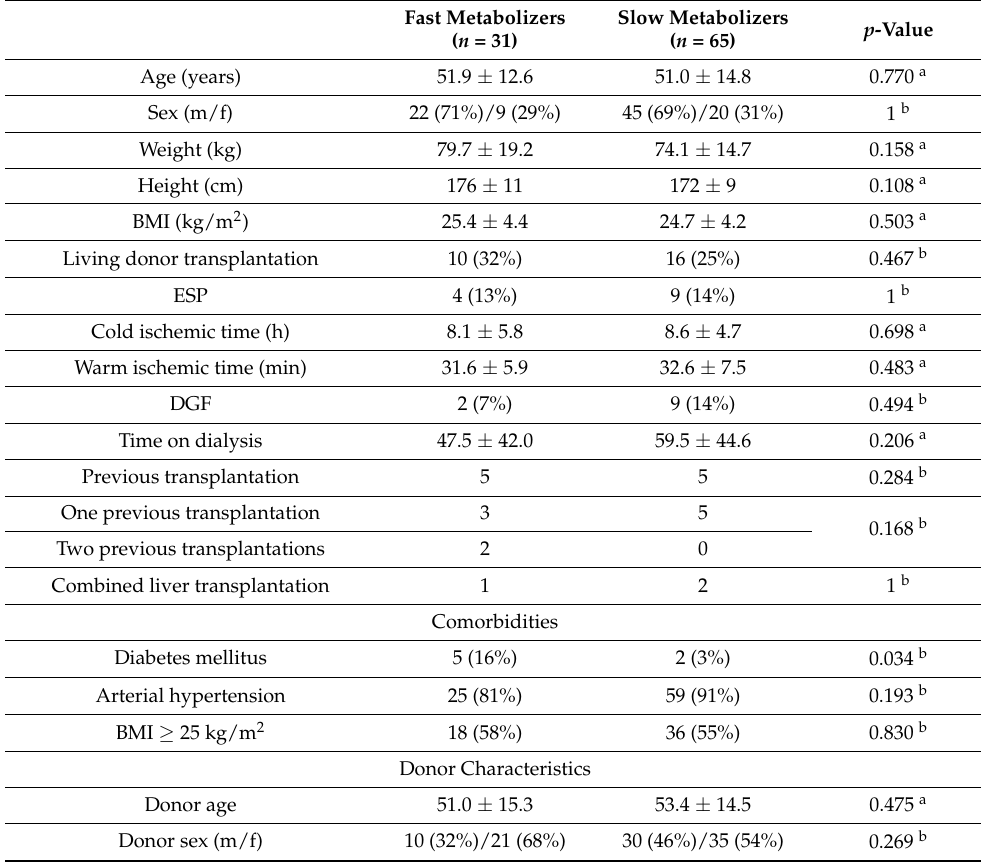
Table 1. Patient characteristics and immunosuppression.